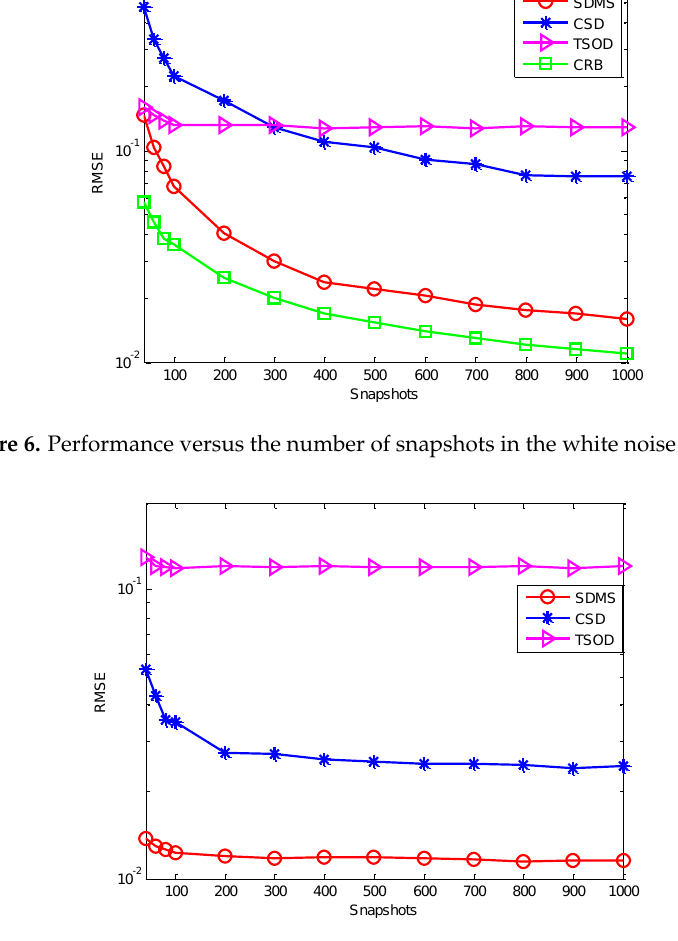
Figure 7. Performance versus the number of snapshots in the colored noise